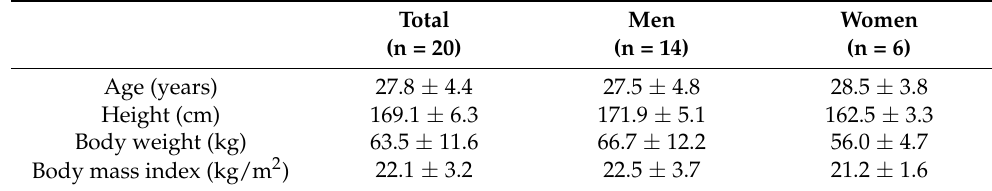
Table 1. Anthropometric characteristics of the study population according to sex.